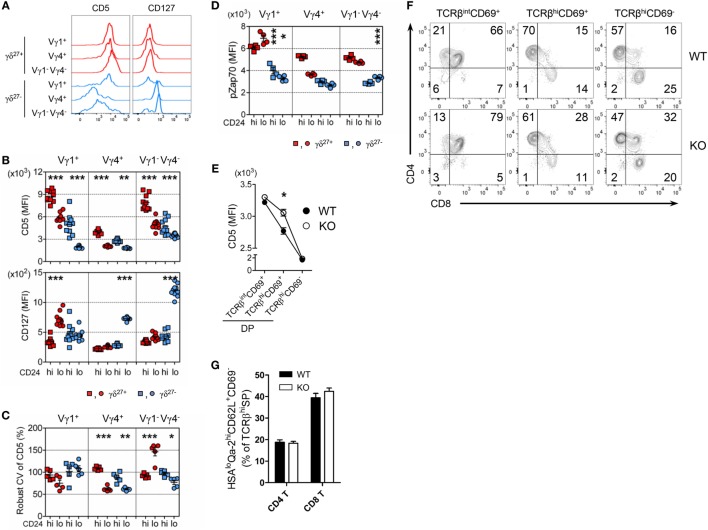
The uniqueness of Vγ4+ γδ27− thymic development. (A) Half-offset histogram of CD5 and CD127 on Vγ1+, Vγ4+, and Vγ1−Vγ4− subsets of γδ27+ or γδ27− cells in peripheral lymph node cells from adult (6-week-old) WT mice. (B–D) MFI of CD5 and CD127 [(B); n = 10], robust coefficient of variation (CV) of CD5 MFI [(C); n = 5], and MFI of phosphorylated Zap70 [(D); n = 4] on CD24hi or CD24lo cells of each subset [indicated as in (A)] from neonatal (day 3 after birth) thymocytes of WT mice. (E–G) MFI of CD5 on TCRβintCD69+, TCRβhiCD69+ and TCRβhiCD69− cells of CD4+CD8+ double-positive (DP) cells (E), density plot of CD4 and CD8 expression on TCRβintCD69+, TCRβhiCD69+ and TCRβhiCD69− cells (F), and percent of CD24loQa-2hiCD62L+CD69− cells among CD4+ or CD8+ TCRβhi cells (G) in thymocytes from WT and KO mice (n ≥ 4). Data (E,G) are mean ± SD. Each symbol (B–D) represents an individual mouse; error bars are the mean ± SD. *P ≤ 0.05; **P ≤ 0.01; ***P ≤ 0.001. Data are representative of at least three independent experiments.